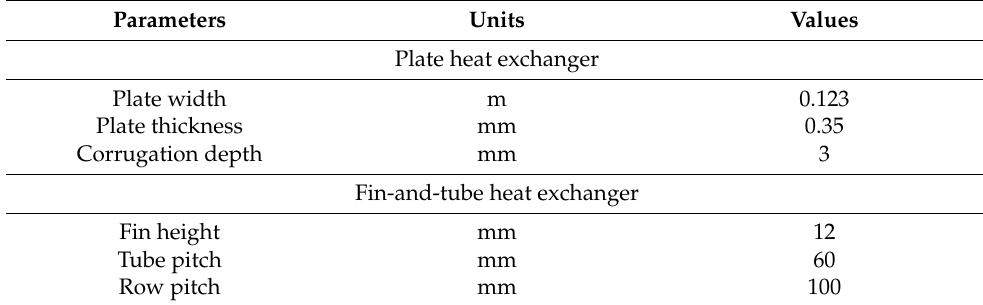
Table 4. Exchangers